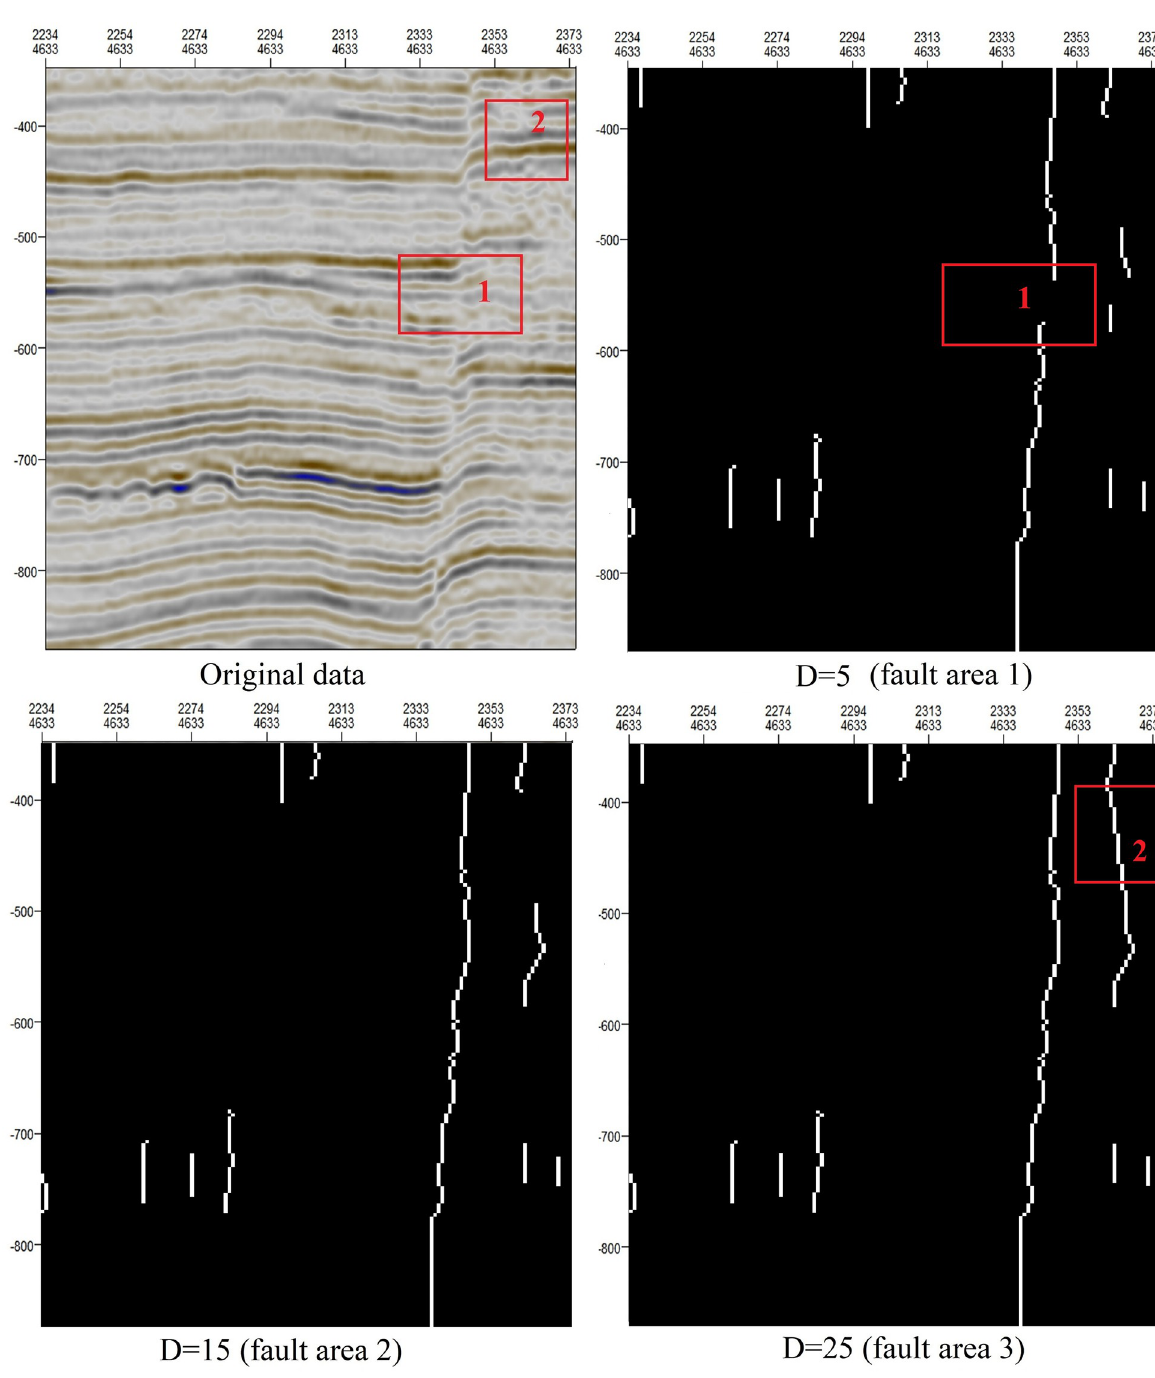
Fig 10. Influence of different values of D on fault